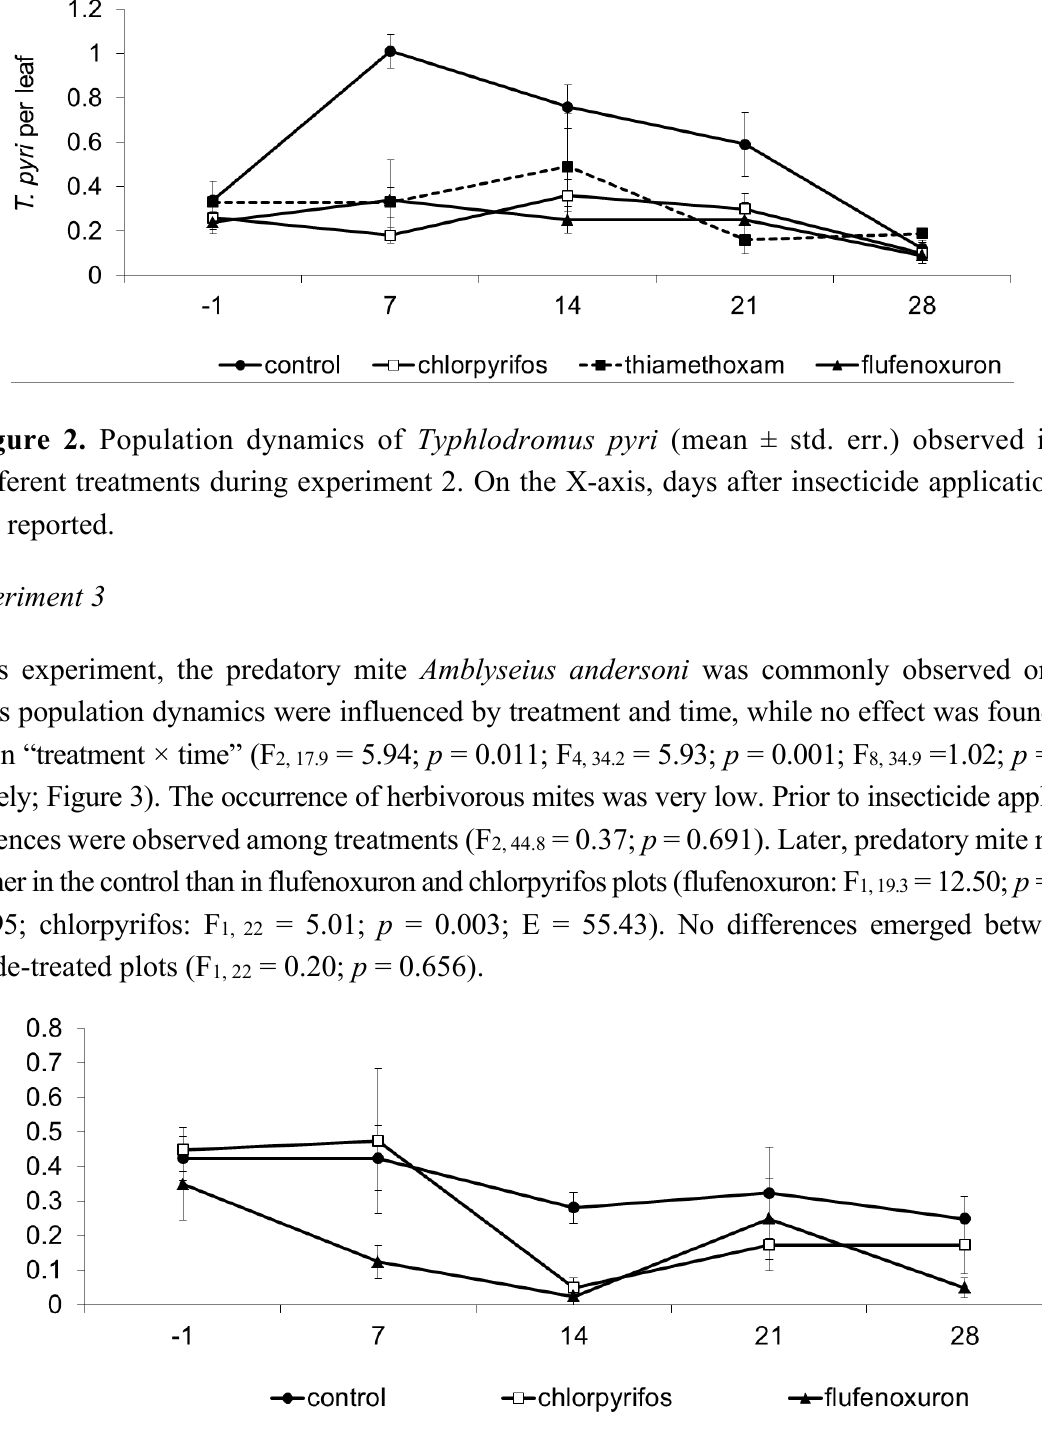
Figure 3. Population dynamics of Amblyseius andersoni (mean ± std. err.) observed